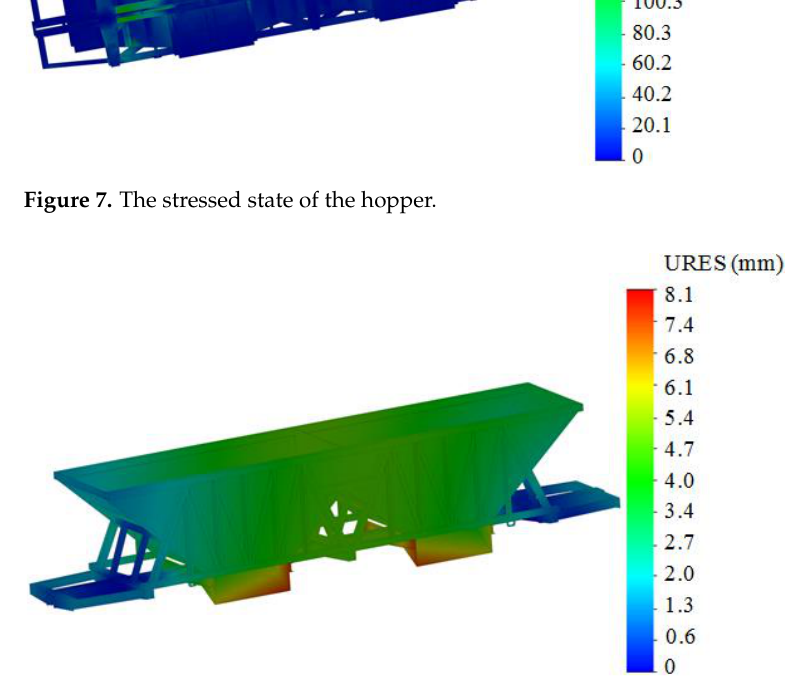
Figure 8. Displacements in the nodes of the hopper wagon.